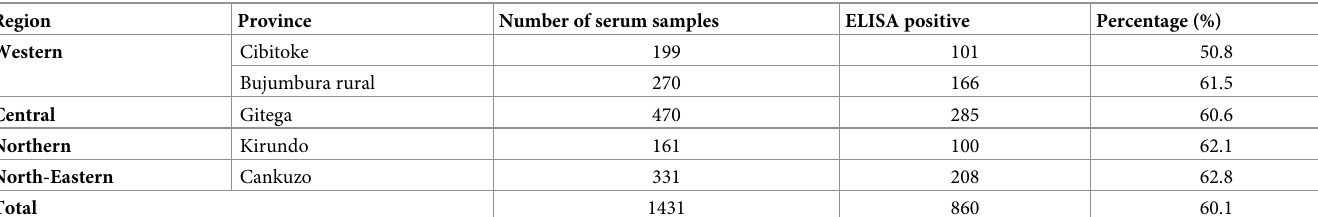
Table 2. Proportion of Theileria parva antibody positive samples collected in different provinces in Burundi. Region